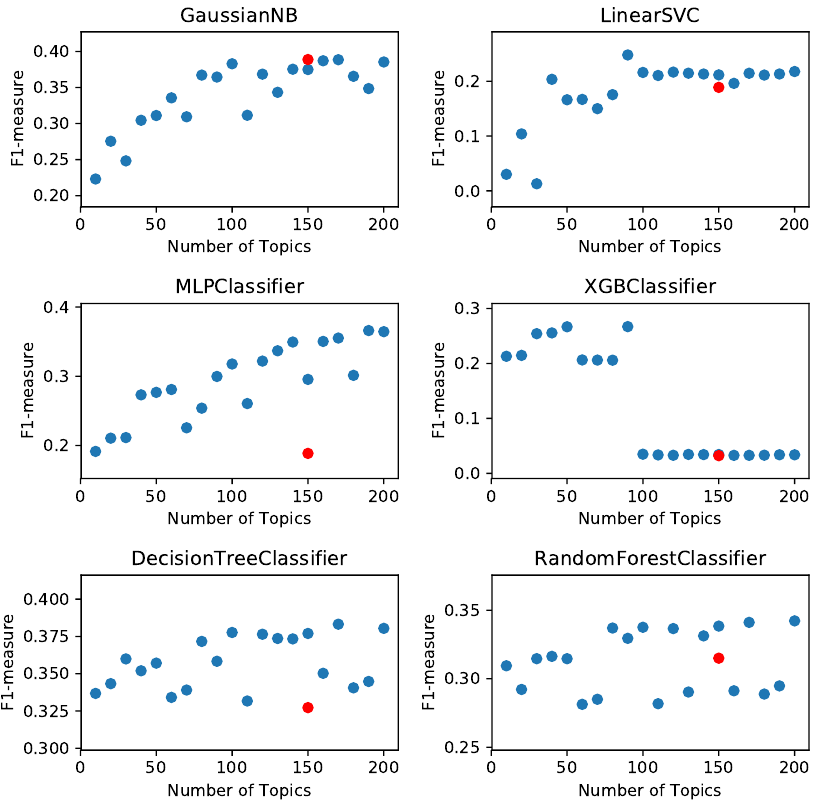
Figure 6. F1 scores using different numbers of topics for LDA with different learning algorithms (in blue), and the results for HDP (in